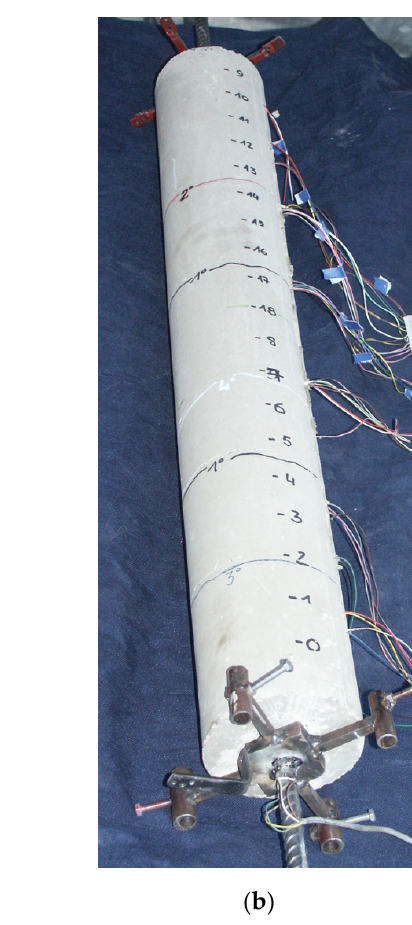
Figure 14. Analytical slip–strain diagram for specimen n.1 ( a ), and the location of the three cracks numbered according to the sequence of occurrence (unit: mm) ( b ).